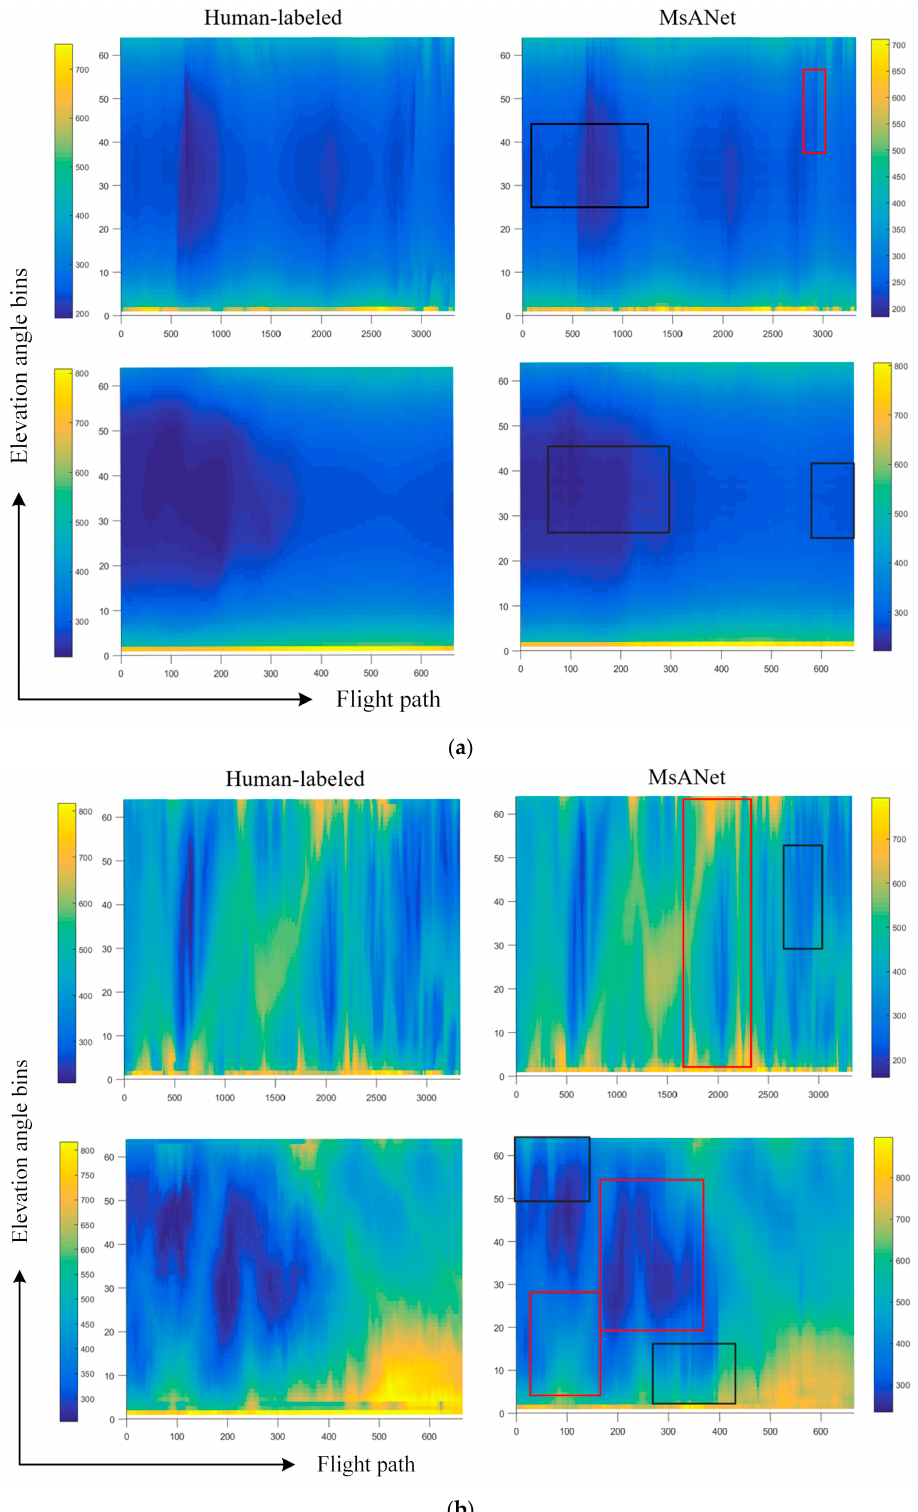
Figure 11. Reconstructions of terrain from results extracted by the MsANet without any interpolation method. Unit: meter. ( a ) Ice-surface layer. ( b ) Ice-bottom layer. The x -axis in each image means the flight path and the y -axis is the scanning width of the MCoRDS, while the color indicates the elevation of layers, which is the depth from the radar. For better observation, red boxes are used to mark the part where the MsANet extracted results are close to the ground truth and black boxes are applied to highlight the part where the MsANet extracted results are not similar to the ground